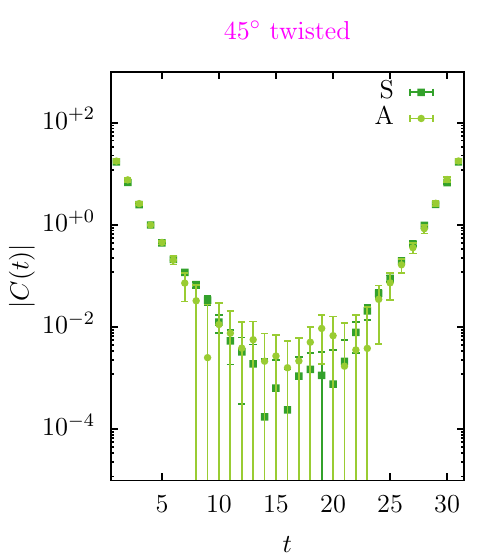
Figure 12 . Comparison of time-symmetric (S) and time-antisymmetric (A) gluino-glue correlator at m = -1.0105, and for n s = 8 stout smearing steps. Absolute values are shown for a better comparison of the cosh- and sinh-shaped